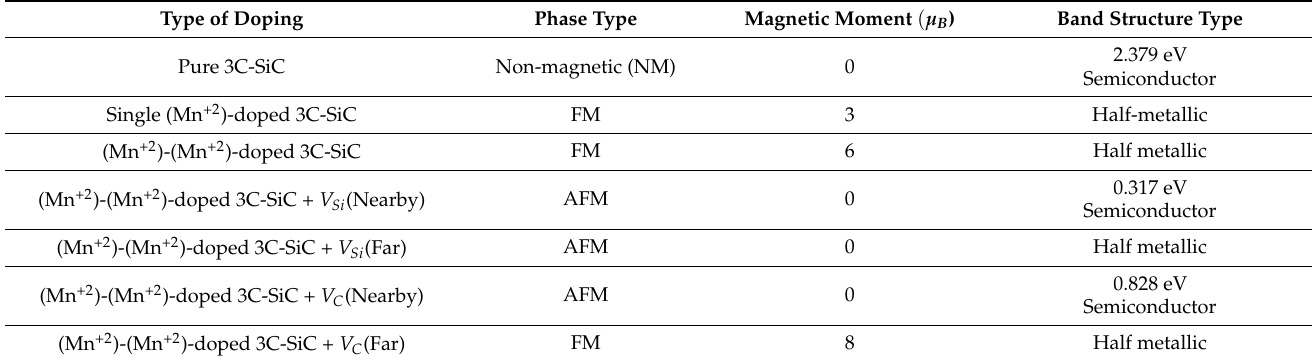
Figure 14. Spin-polarized ( a ) total density of state (TDOS) and ( b ) partial DOS (PDOS) of double (Mn +2 )-doped 3C-SiC Carbon-vacancy far FM. ( c ) Blue spin up and ( d ) red spin down band structure. Fermi Level indicated by a red and black dash line. Table 3. Calculated magnetic moment of (Mn +2 )-doped 3C-SiC and band structure type of studied systems.